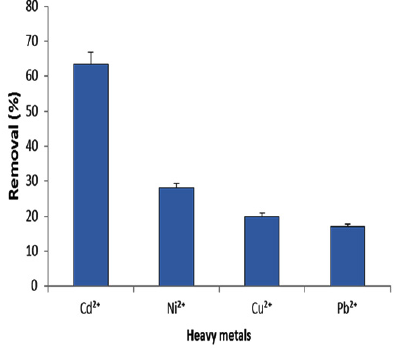
Fig. 13. Removal efficiency of different heavy metals by silver nanoparticles synthesized by marine Pseudomonas sp .